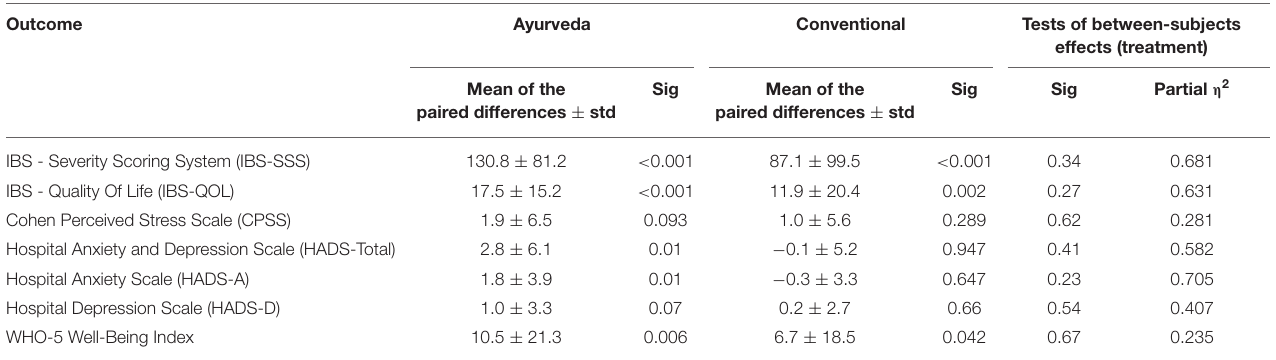
TABLE 4 | The means of the paired differences between outcome at baseline and after 3 months (paired samples test) and the effect of treatment (test of between-subjects effects). Outcome Ayurveda Conventional Tests of between-subjects